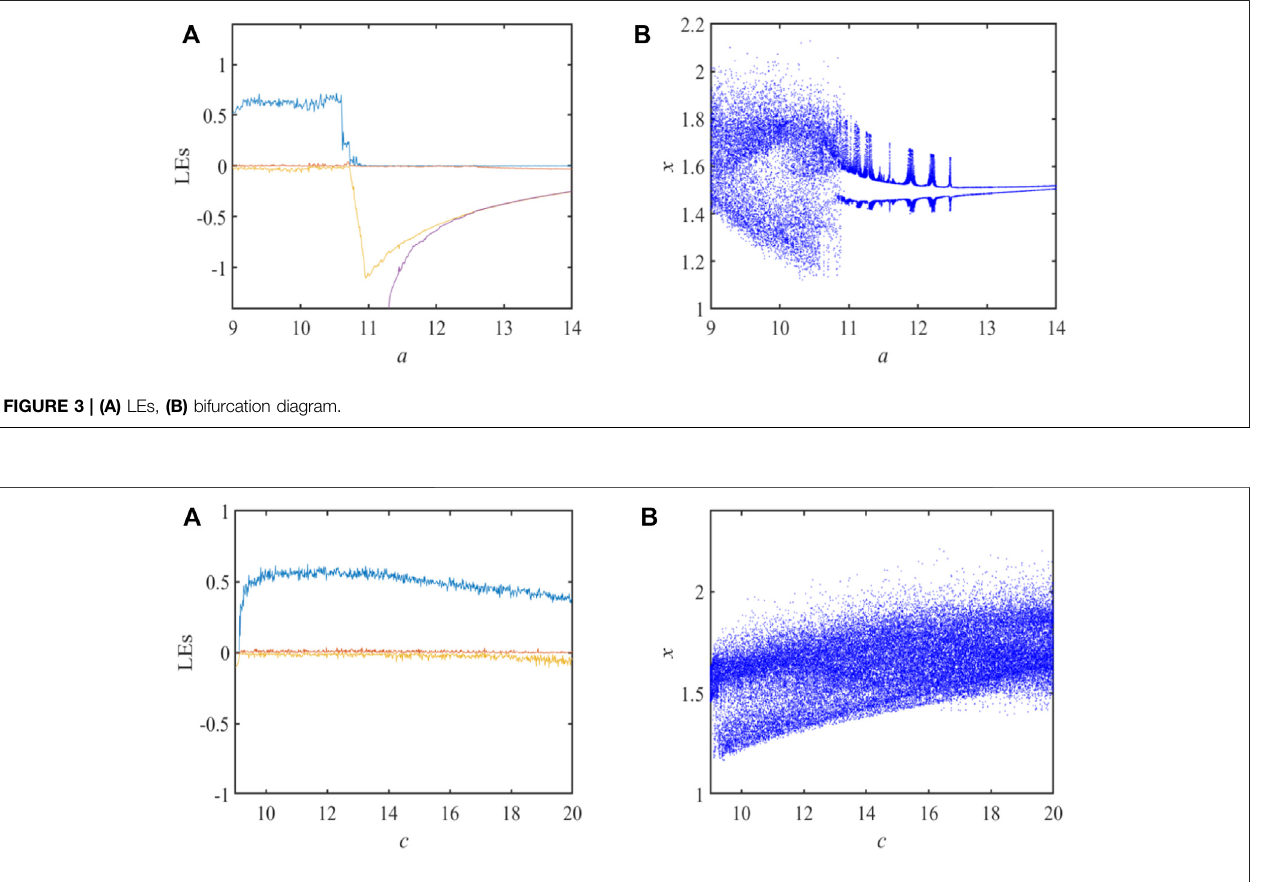
FIGURE 4 | (A) LEs, (B) bifurcation diagram.